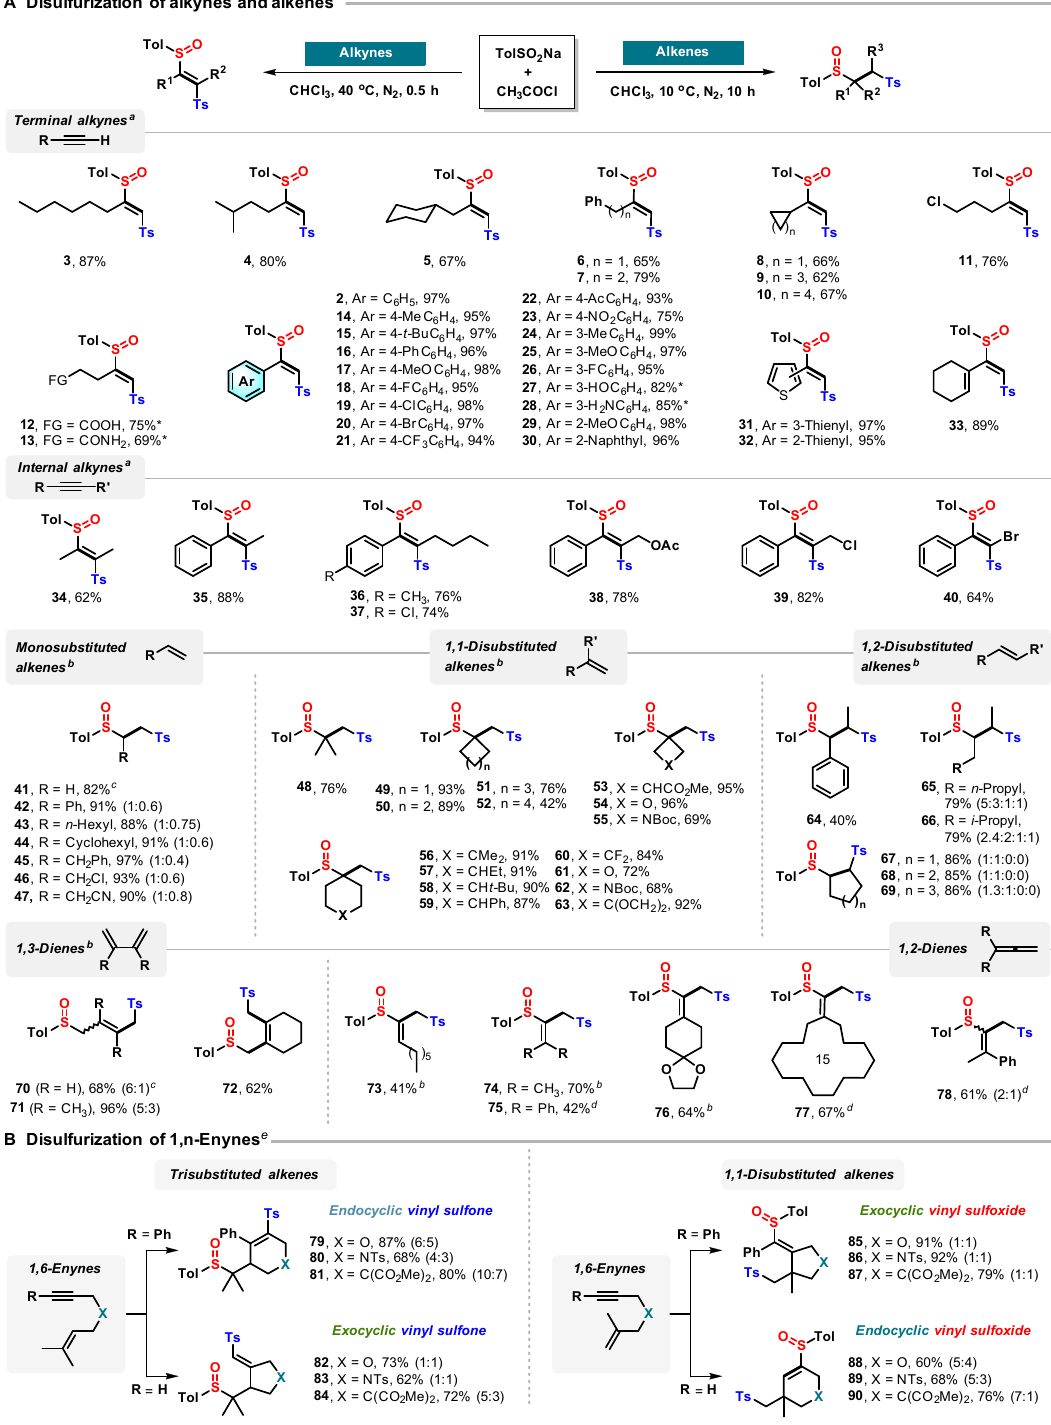
Fig. 2 The sul fi nylsulfonation of unsaturated hydrocarbons. A Sul fi nylsulfonation of alkynes and alkenes; B cascade sul fi nylsulfonation of enynes. All yields are isolated yields. Diastereomeric ratios are shown in parentheses where appropriate. Amounts of reagents and solvent: alkyne/alkene/enyne (0.3 mmol), TolSO 2 Na (1.8 mmol), CH 3 COCl (1.2 mmol), 0.1 M in CHCl 3 , N 2 . a 40 °C, 30 min. b 10 °C, 10 h. c Reaction conditions for gaseous ole fi ns: TolSO 2 Na (1.8 mmol), CH 3 COCl (1.2 mmol), CHCl 3 (3 mL), 10 °C, 20 h, ethylene/1,3-butadiene (1 atm); the yield of product was calculated using TolSO 2 Na as the standard. d 40 °C, 5 h. e Room temperature, 8 h. *Reaction conditions for the synthesis of 12 , 13 , 27 , and 28 : alkyne (0.3 mmol), 1 (0.45 mmol), 0.1 M in CHCl 3 , N 2 , 40 °C, 0.5